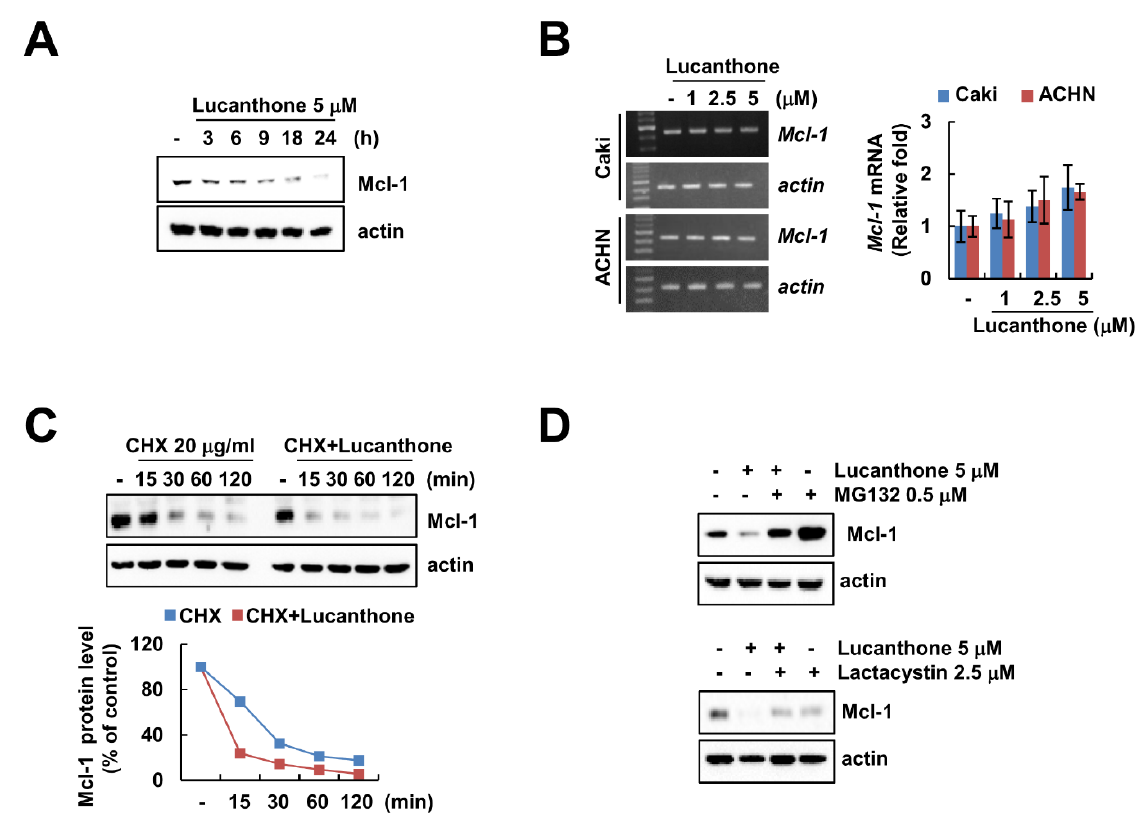
Figure 3. Lucanthone decreases Mcl-1 expression through the ubiquitin–proteasome pathway. ( A ) Caki and ACHN cells were treated with 5 µ M lucanthone for the indicated time periods; ( B ) Caki and ACNH cells were treated with 1–5 µ M lucanthone for 24 h. The mRNA levels of Mcl-1 and actin were quantified by RT-PCR and qPCR; ( C ) Caki cells were pretreated with 20 µ g/mL cycloheximide (CHX) for 30 min and then treated with 5 µ M lucanthone for the indicated time periods. The band intensity was examined using Image J; ( D ) Caki and A549 cells were pretreated with 0.25 µ M MG132 or 2.5 µ M lactacystin for 30 min and then treated with 5 µ M lucanthone for 24 h. The protein expression was measured by Western blotting. The values in graph represent the mean ± SD of three independent samples.